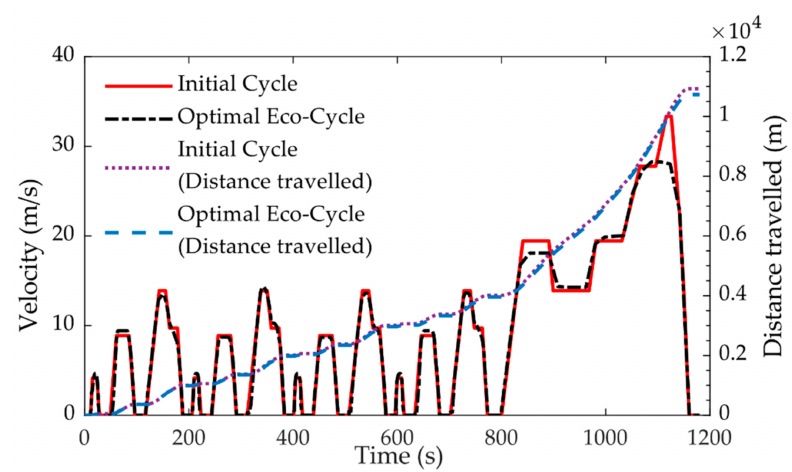
Figure 8. Optimized speed trajectory for the New European Driving Cycle (NEDC) ( β = 0.5).